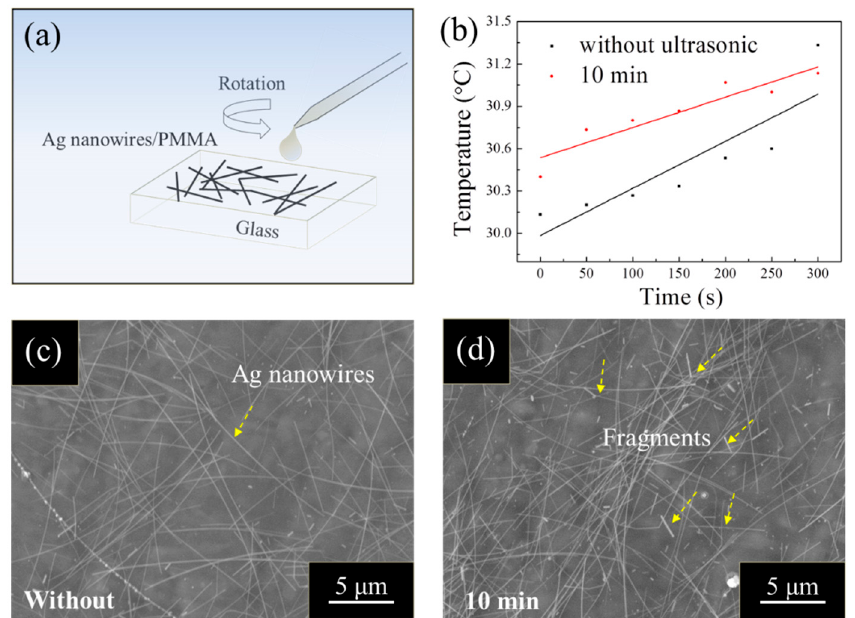
Figure 1. ( a ) A schematic of the structure of the Ag nanowires based film heater; ( b ) temperature rise of the Ag nanowires based film heaters; ( c , d ) top-views of Ag nanowires based film heater without and with ultrasonic treatment. Partial fragments of Ag nanowires were highlighted by yellow dot square frames. Table 1. Resistivity of Ag NWs/PMMA/glass in Figure 1c,d without and with ultrasonic treatment, respectively. Resistivity ( Ω /sq) Avg. Without